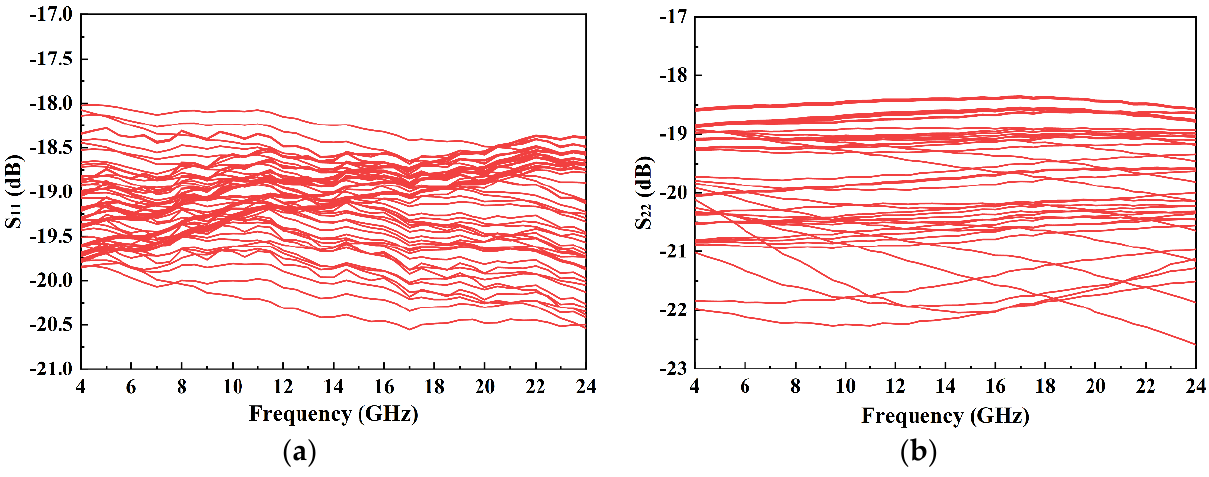
Figure 19. The measured ( a ) 𝑆 11 and ( b ) 𝑆 22 of all states.